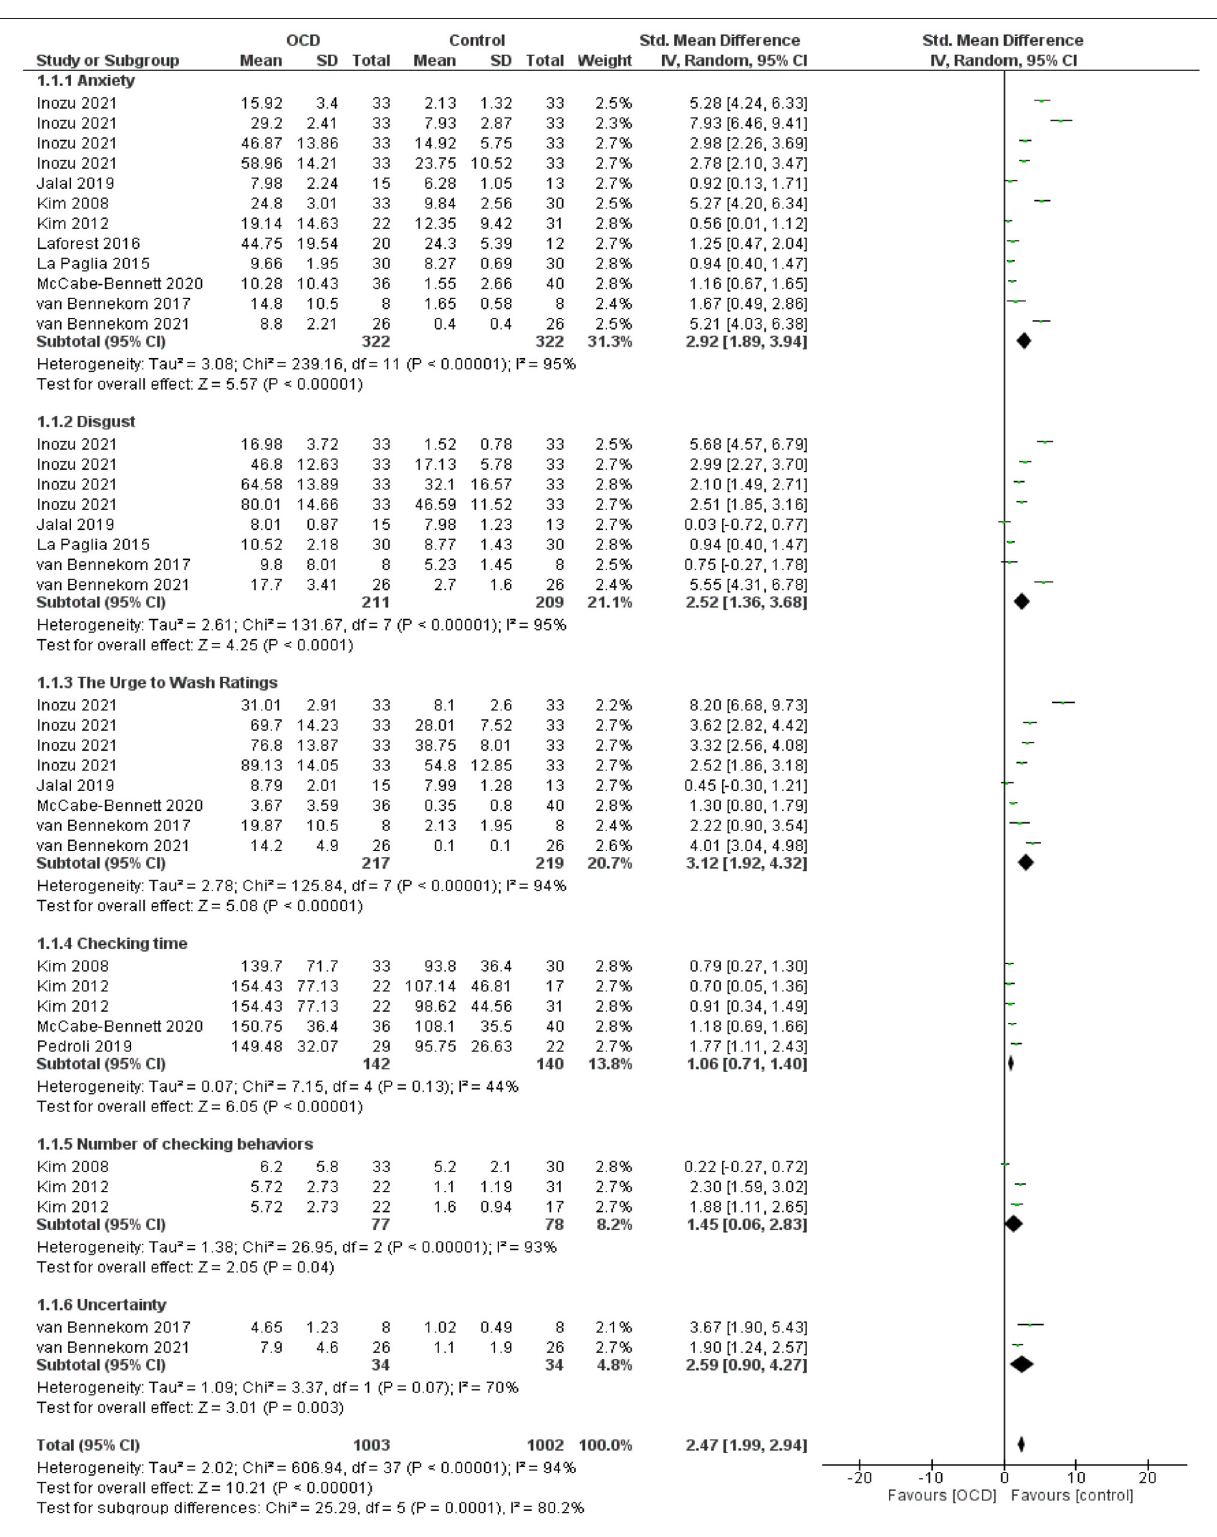
Frontiers in Psychiatry |